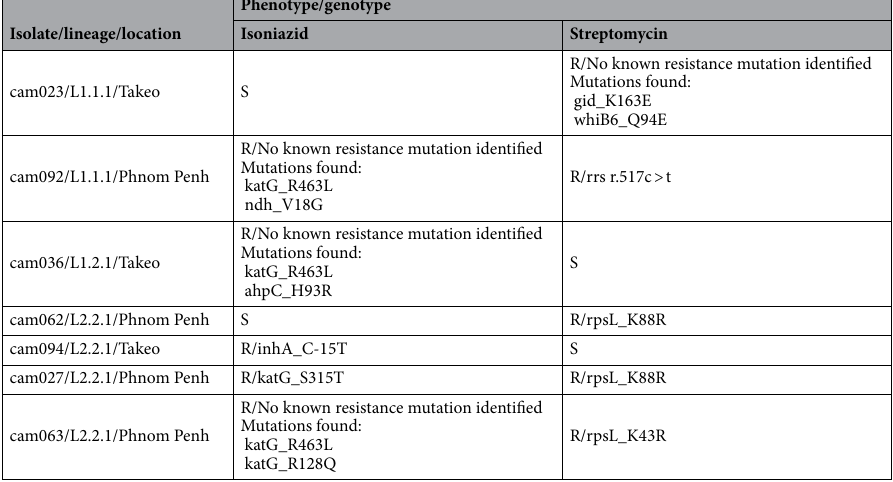
Table 1. Correlating genotypic variants with phenotypic resistance to TB drugs, grouped by lineages. For the additional non-synonymous mutations identified within genes associated with resistance, katG_R463L had been reported not to be associated with isoniazid resistance: R resistant, S